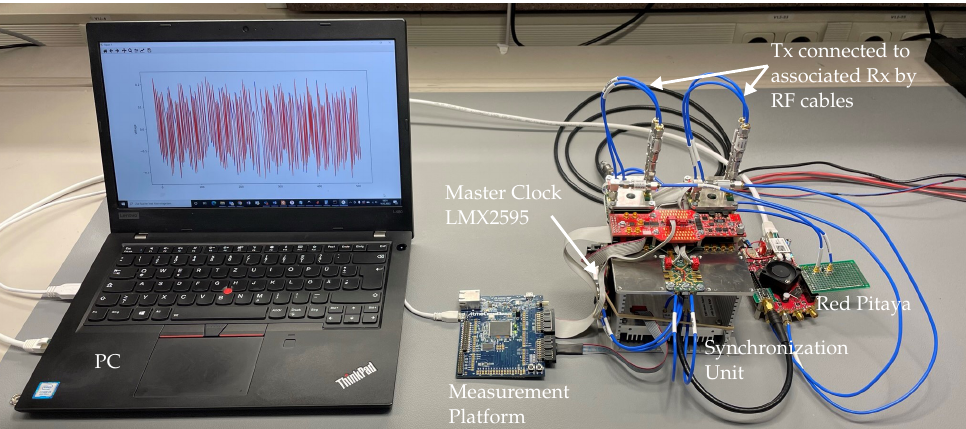
Figure 12. Prototype test setup of the standalone measurement node. Each Tx is back-to-back to its associated Rx with 21dB signal attenuation. Synchronously recorded M-sequences of 9th order are shown on the